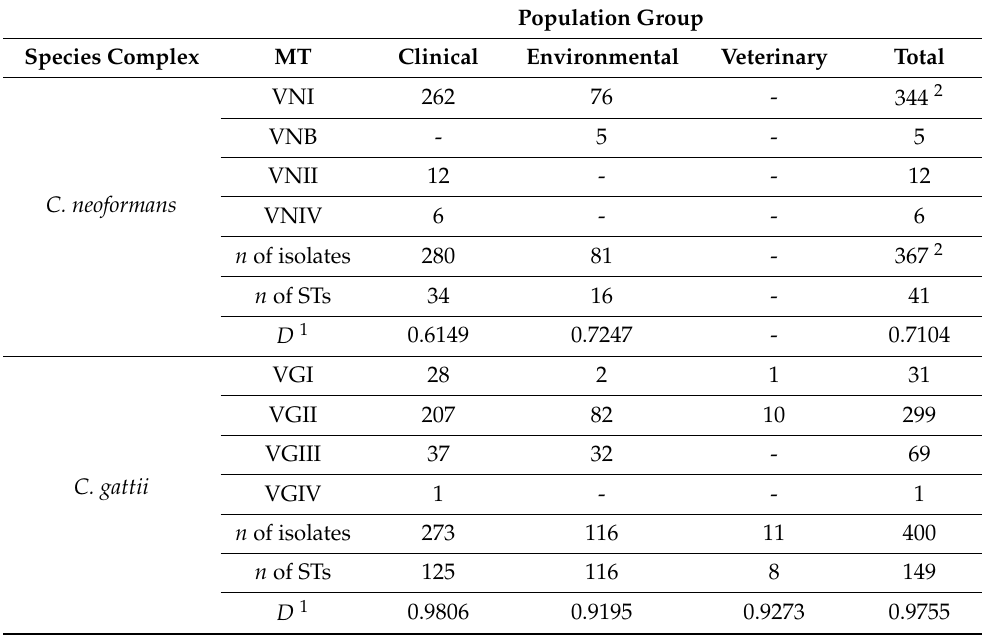
Table 2. Genotypic diversity of the Cryptococcus neoformans and Cryptococcus gattii species complexes populations from Latin America, according to multilocus sequence typing